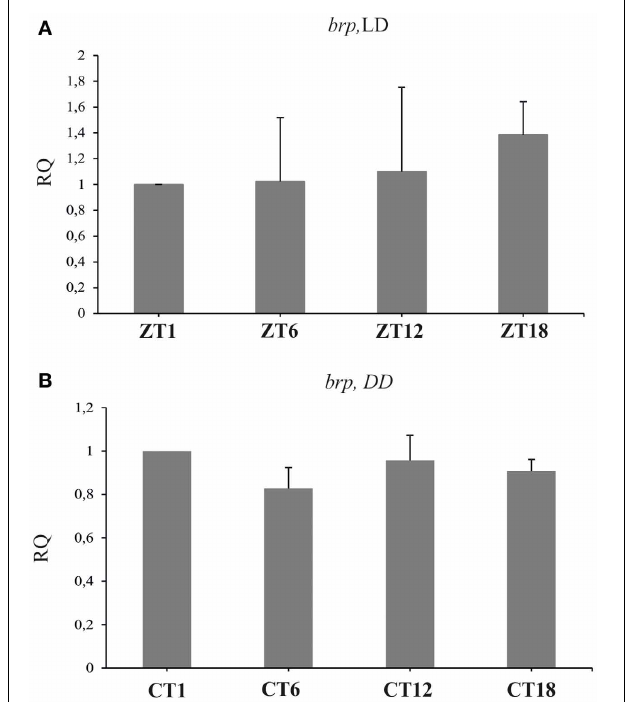
FIGURE 2 | The relative level of brp mRNA in the brain of flies raised in LD 12:12 (A) and in constant darkness (B). The level of brp mRNA is constant during the day and night in LD and